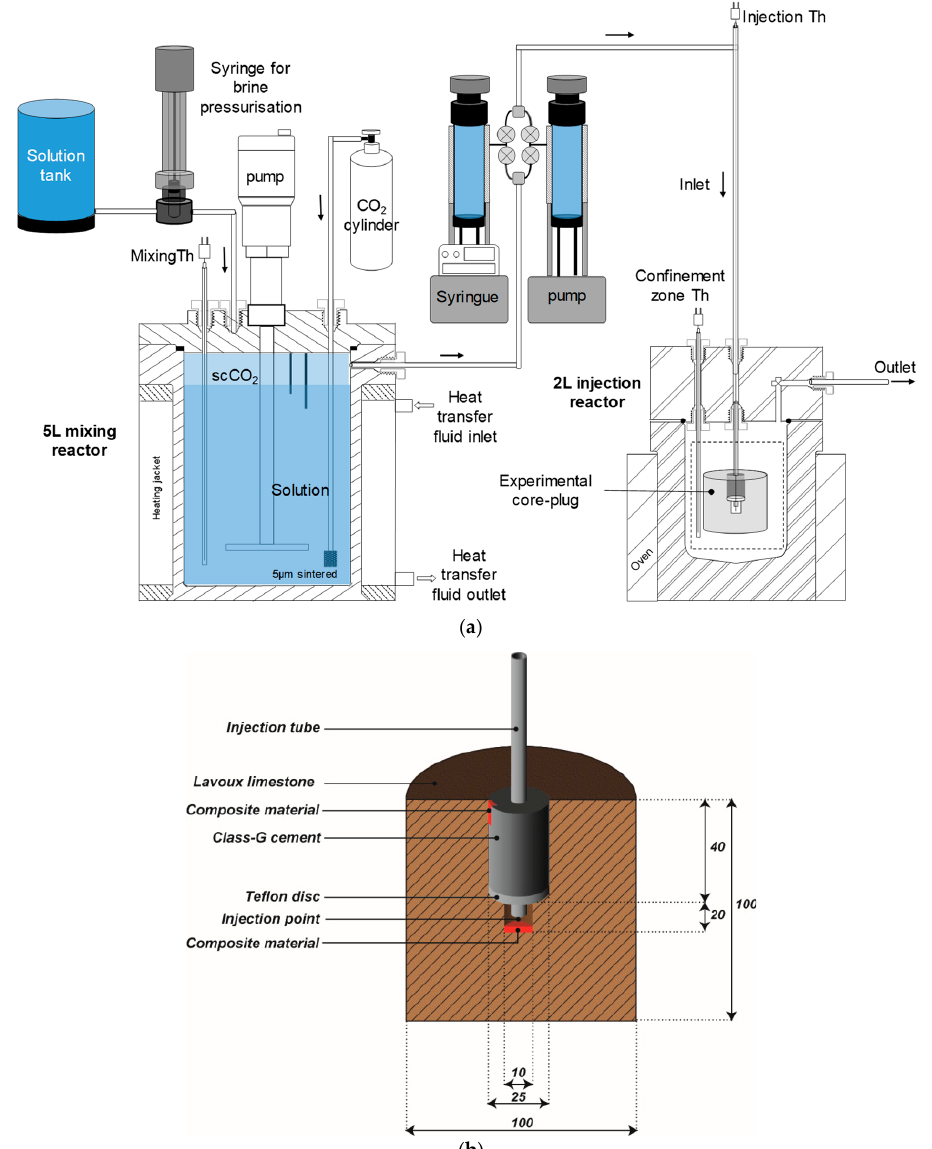
Figure 1. ( a ) Experimental device (MIRAGES-2) used to inject the CO 2 -rich solution in the core-plug under controlled conditions of pressure, temperature, and flow rate; ( b ) schematic view of the core-plug and the injection well. Dimensions are provided in millimetres.